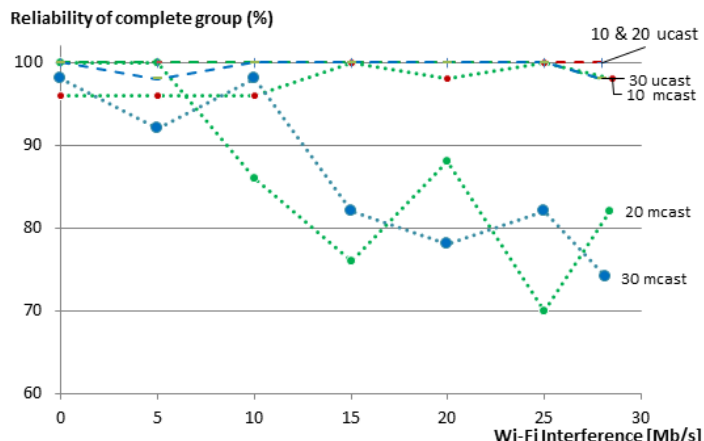
Figure 11. Entity reliability for both unicast and multicast group communication and varying group sizes in the presence of Wi-Fi interference. The reliability of the complete group is less than the reliability of individual members (Figure 10). Again, the reliability of the complete group is much better when using entity-based group communication.